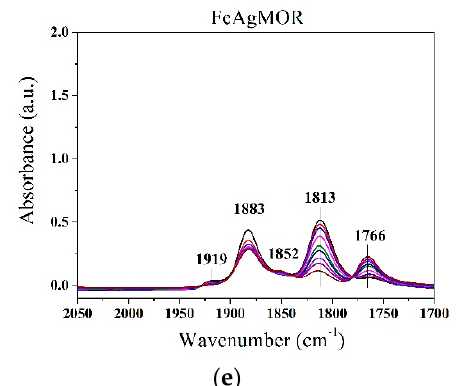
Figure 1. FTIR spectra of adsorbed NO on studied samples. ( a ) NaMOR; ( b ) AgMOR; ( c ) FeMOR; ( d ) AgFeMOR, and ( e ) FeAgMOR. All spectra are normalized with respect to the pellet thickness and reported in the same vertical range for easier comparison. The spectra are measured by dosing NO; the NO pressure is decreased from 70 mBar (black dotted line) to a dynamic vacuum of 5.0 × 10 − 4 mBar (cherry dotted line). Insets in panels ( a ) and ( b ) report a magnification of the corresponding (very weak) spectra.